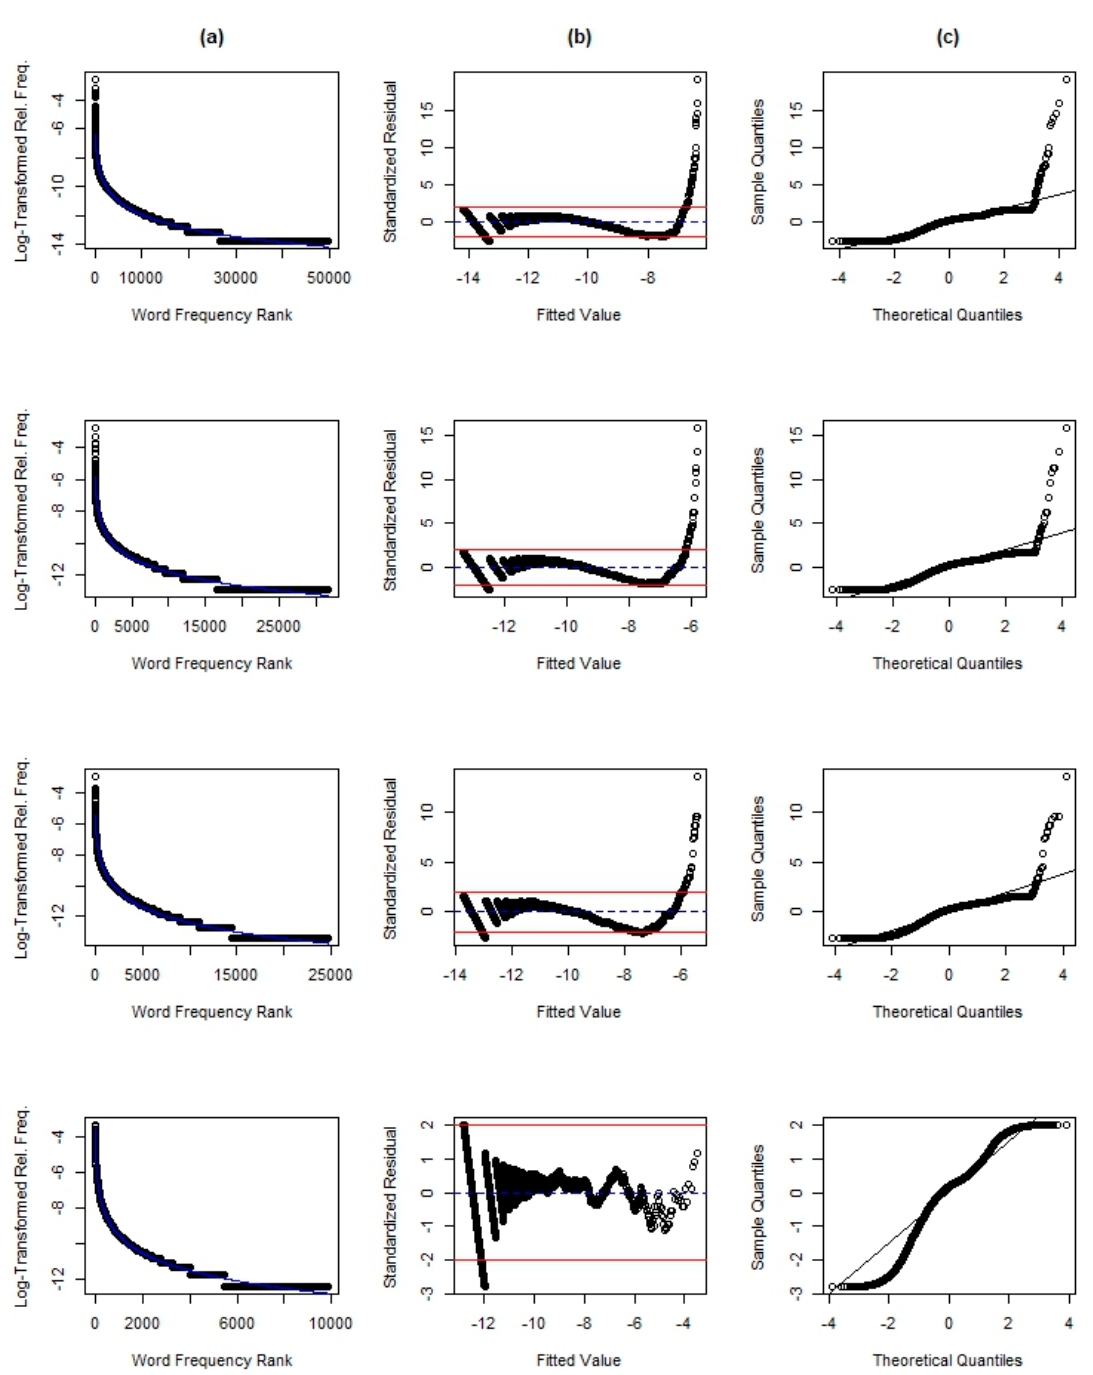
Figure 1. Analyzing Kolhapur, International Corpus of English (ICE)-Written, ICE-Spoken, and Elite New Dehli English (ENDE) corpora fit to Mandelbrot’s Law. Each row corresponds to those corpora respectively. ( a ) Plot of fitted values (blue curve) relative to the observed log-transformed relative frequencies; ( b ) Standardized residuals plot with expected value of 0 indicated with a dashed blue line and extreme values at ± 2 demarcated with solid red lines; ( c ) Quantile-Quantile (QQ) plot of standardized residuals with accompanying line connecting the first and third quartiles to illustrate deviations from the observed distribution. We see that the ENDE corpus has the best fit to Mandelbrot’s Law, as visible by a narrower range and smaller absolute values for residuals.